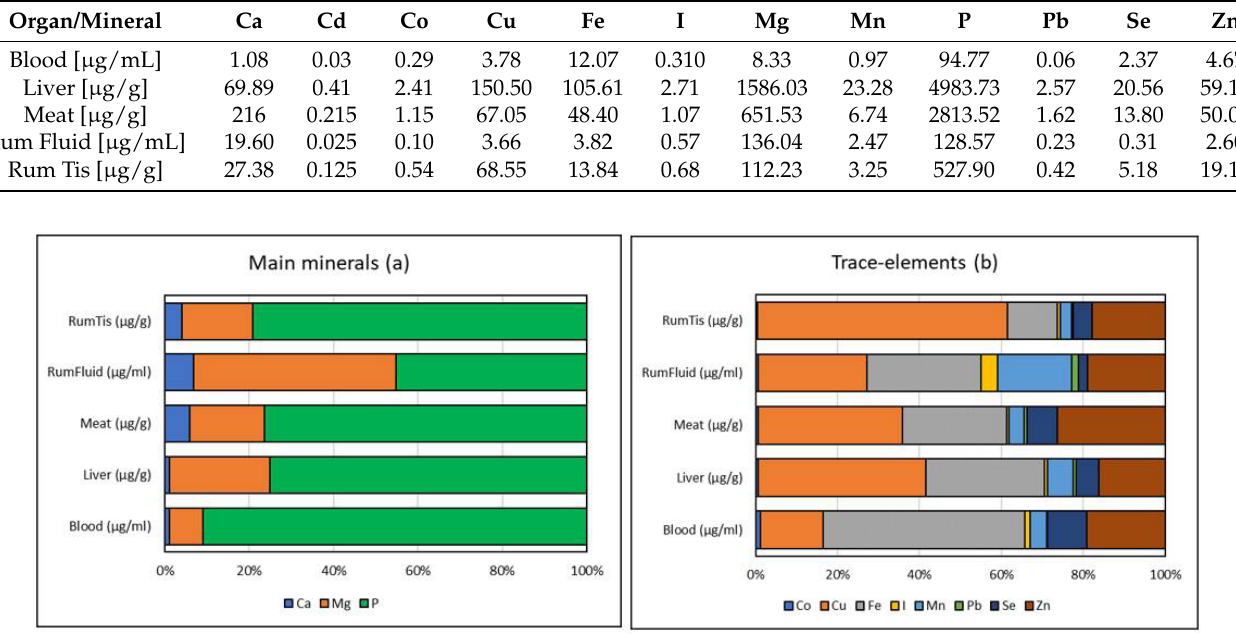
Table 4. Mean values of minerals in the different camel organs and fluids.